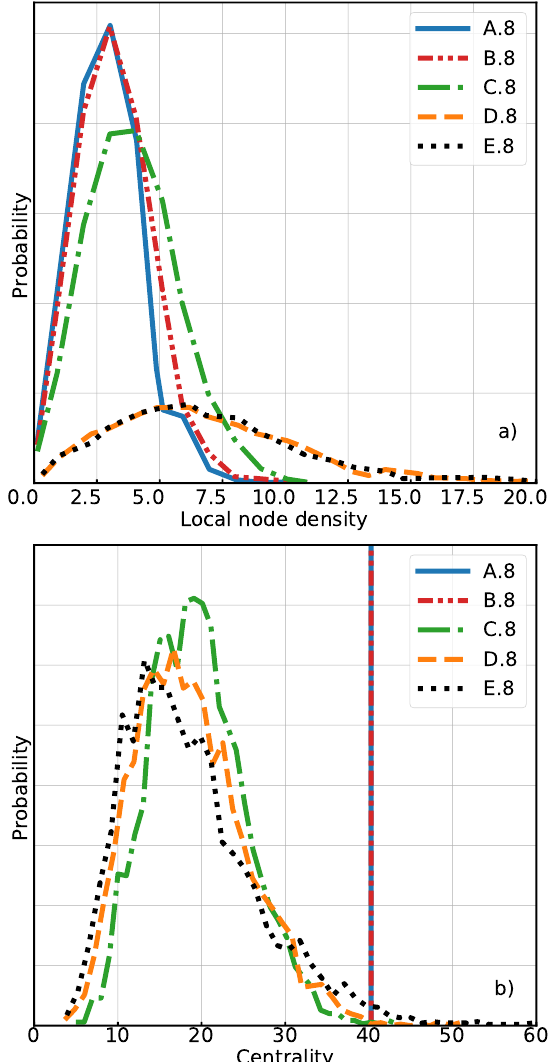
Figure 5. The probability distributions of the ( a ) local node density and ( b ) centrality of networks with a mean node connectivity equal to